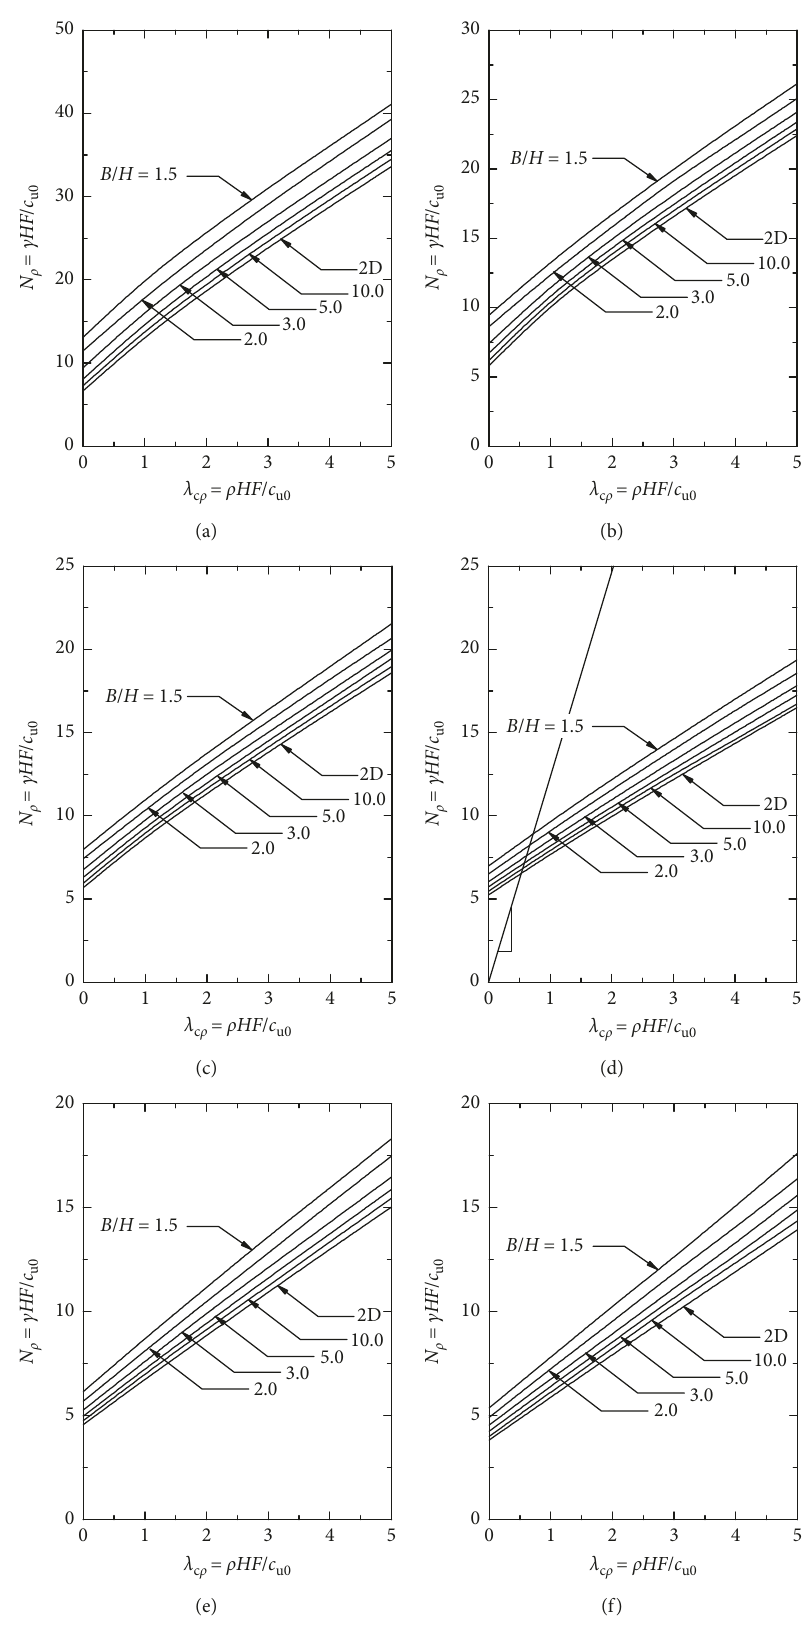
Figure 4: Static stability charts for natural slopes. (a) β � 15 ° . (b) β � 30 ° . (c) β � 45 ° . (d) β � 60 ° . (e) β � 75 ° . (f) β � 90 °